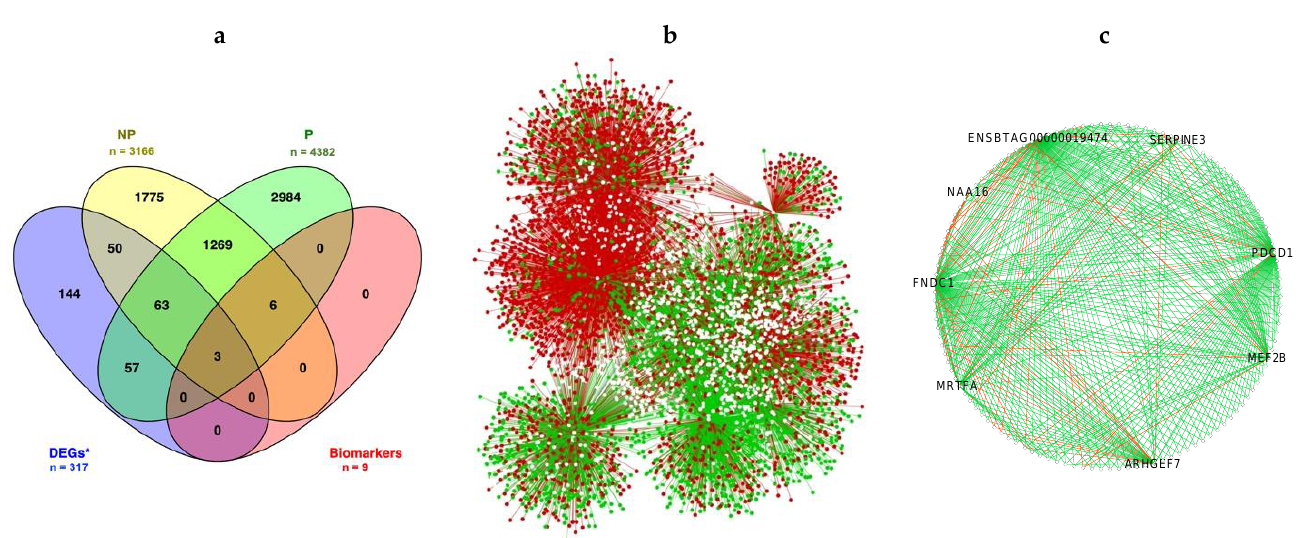
Figure 3. Uterine luminal epithelial co-expressed genes between pregnant (P) and non-pregnant (NP) cows. ( a ) Genes that overlap across analyses; *DEGs – differentially expressed genes from Martins et al. [21]; Biomarkers were identified through machine learning. ( b ) Central reference union networks between the P and NP groups, with 6202 nodes (genes) and 9020 edges (interactions); ( c ) Only gene pairs that are co-expressed with a candidate biomarker are shown; red and green lines (connections) represent negative and positive correlation, respectively.